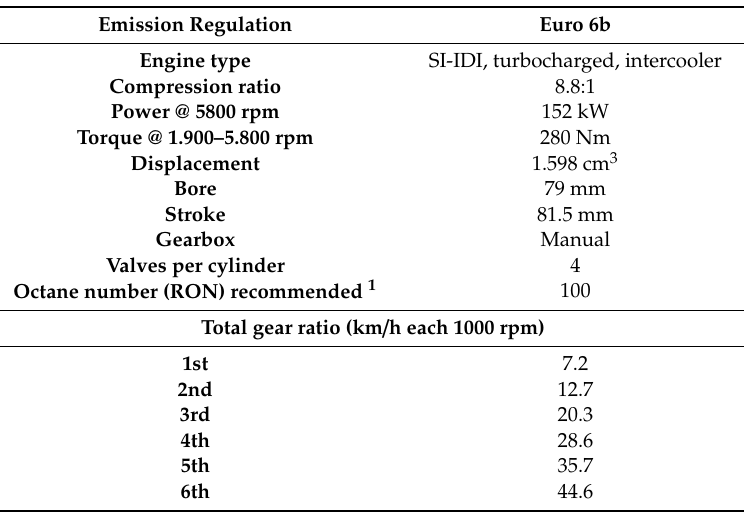
Table 2. Specifications of Opel Corsa OPC.